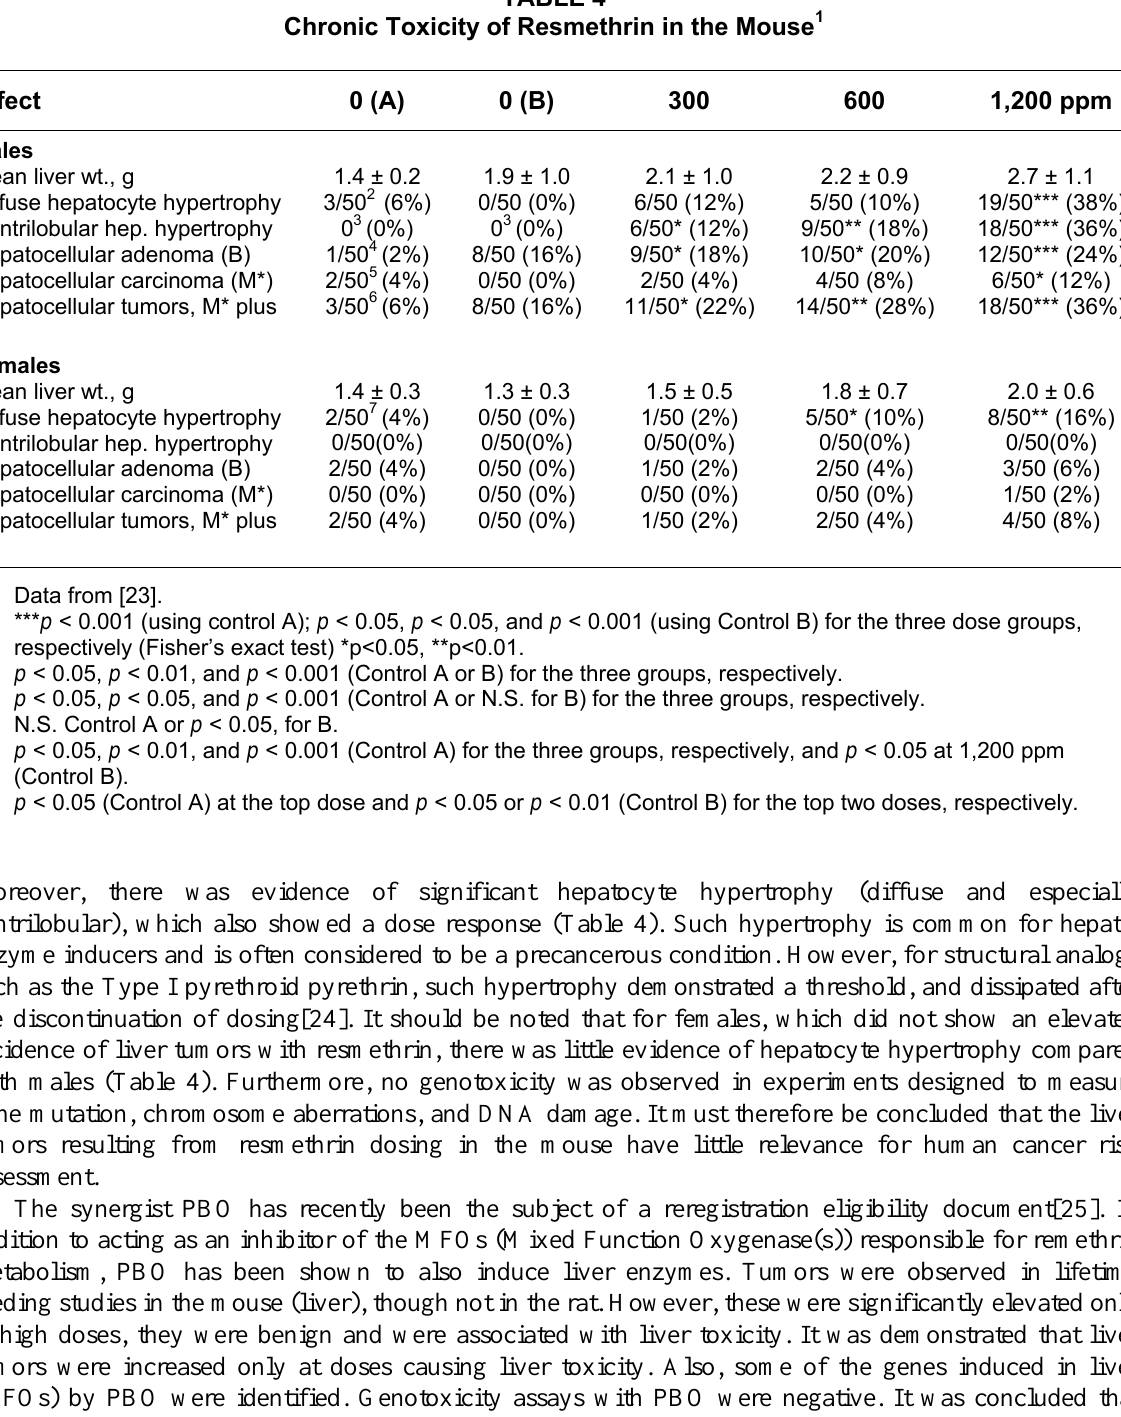
Chronic Toxicity of Resmethrin in the Mouse